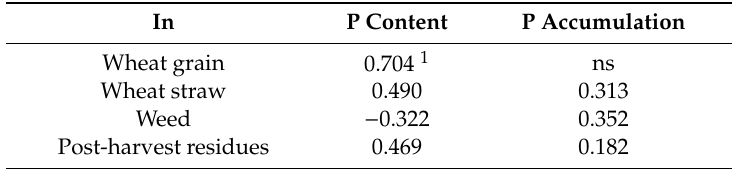
Table 8. Relationship between P content and P accumulation in plant biomass parts and total soil P content—simple correlation coe ffi